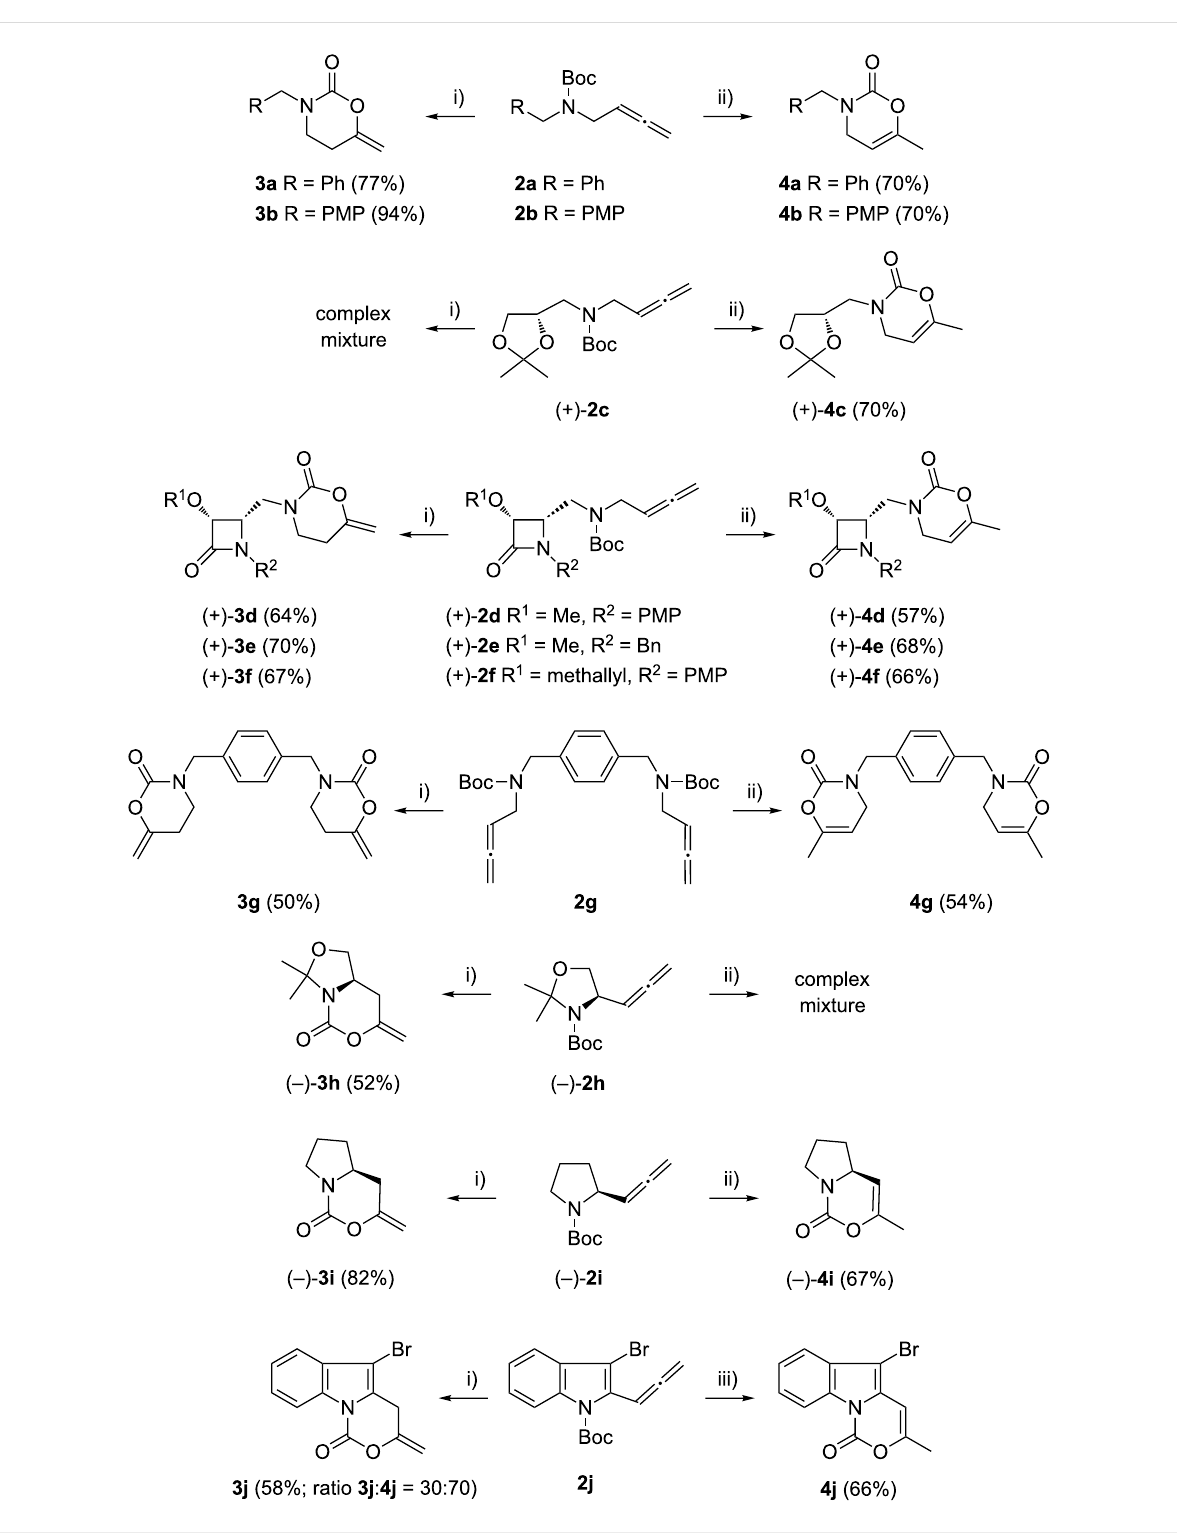
Scheme 2: Controlled oxycyclization reactions of allenic carbamates 2 to 1,3-oxazinan-2-ones 3 and 1,3-oxazin-2-ones 4 under selective gold- catalyzed conditions. Reagents and conditions: (i) 2.5 mol % [AuClPPh 3 ], 2.5 mol % AgOTf, 10 mol % PTSA, CH 2 Cl 2 , rt, 3a : 6 h; 3b : 7 h, 3d : 6 h; 3e : 8 h; 3f : 7 h; 3g : 5.5 h; 3h : 5 h; 3i : 7 h; 3j : 2 h. (ii) 2.5 mol % [AuClPPh 3 ], 2.5 mol % AgOTf, 10 mol % PTSA, CH 2 Cl 2 , sealed tube, 130 °C, 4a : 1.5 h; 4b : 2 h, 4c : 4 h; 4d : 6 h; 4e : 4 h; 4f : 0.5 h; 4g : 5.5 h; 4i : 2 h. (iii) 2.5 mol % [AuClPPh 3 ], 2.5 mol % AgOTf, 10 mol % PTSA, CH 2 Cl 2 , sealed tube, 80 °C, 4j : 2 h. PMP = 4-MeOC 6 H 4